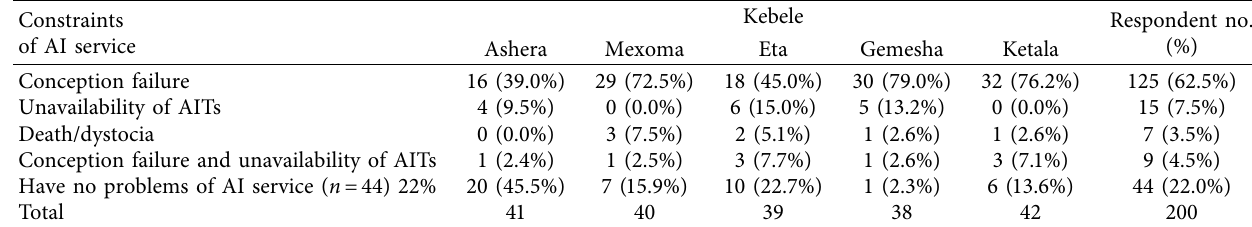
Table 4: Chief constraints of AI provision recognized in survey